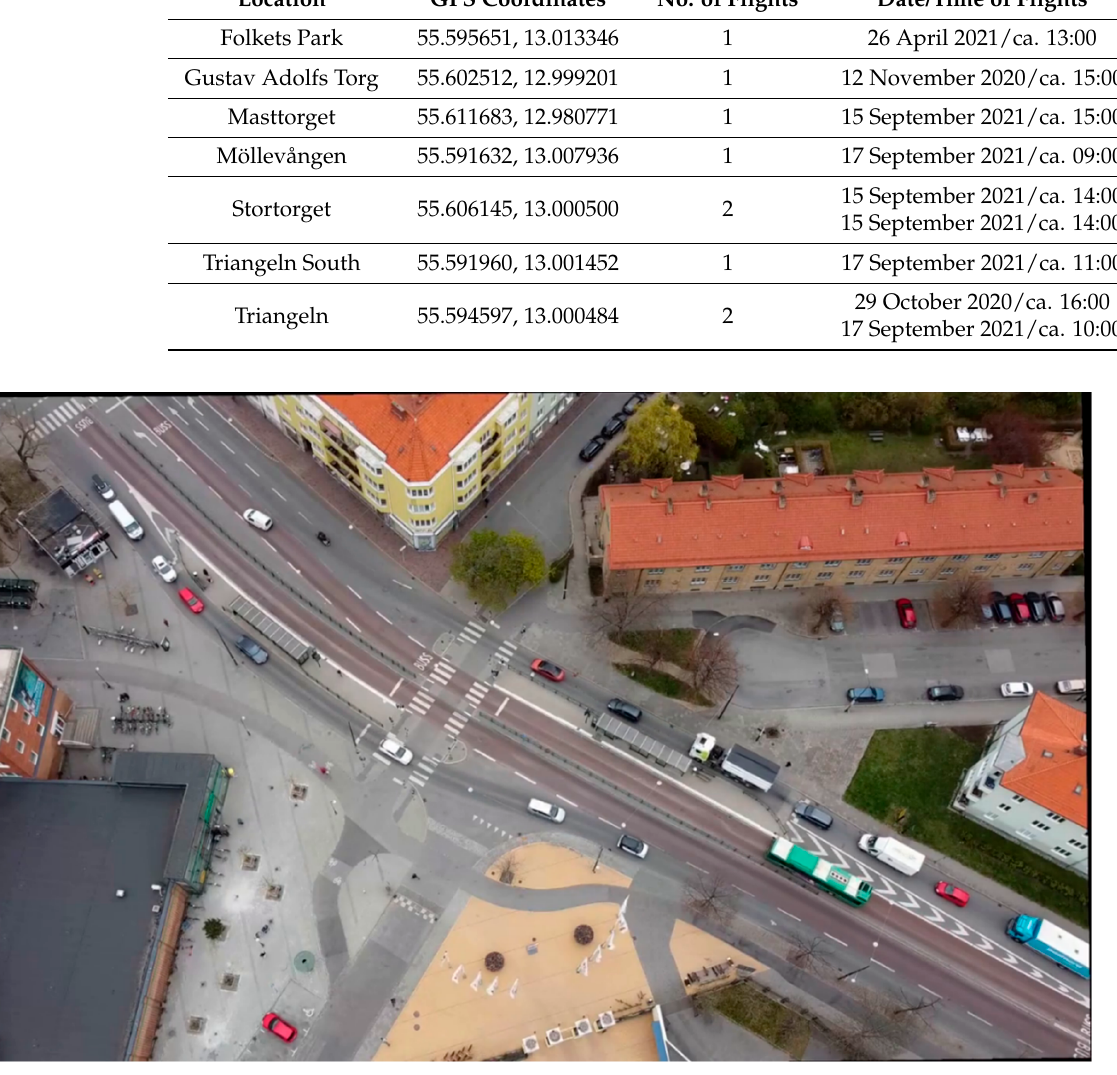
Figure 2. Image from drone footage at Folkets Park, Malmö.